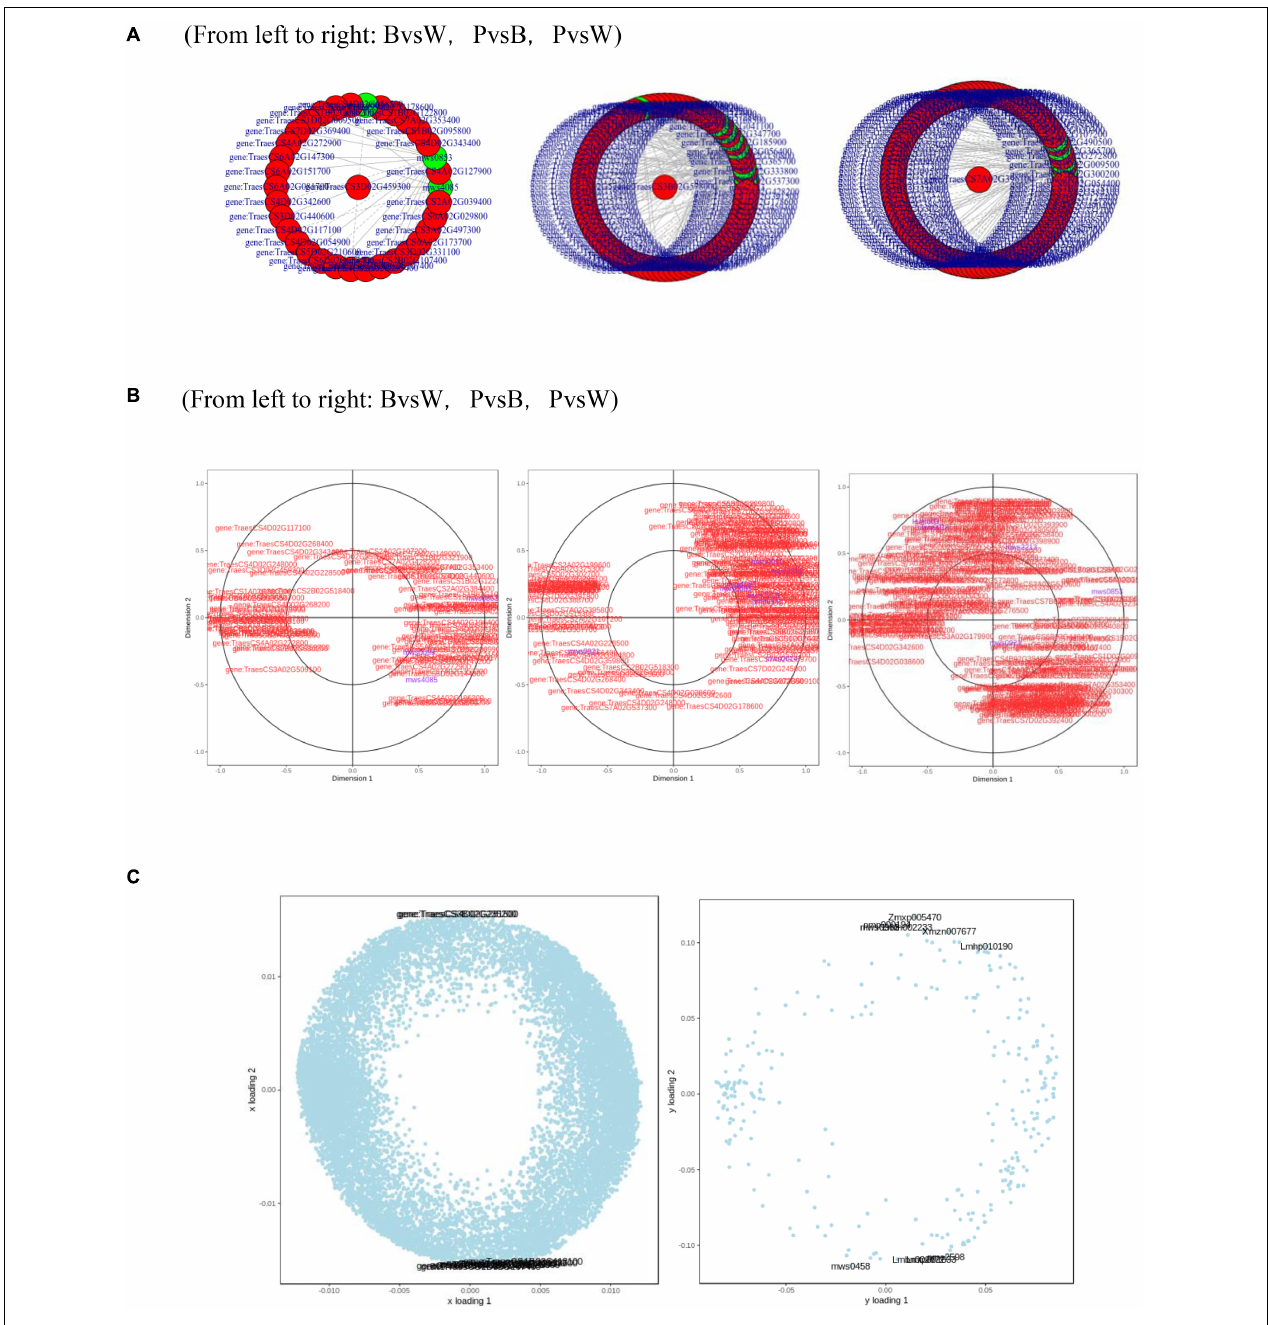
FIGURE 7 | (A) Network diagram of correlations between metabolites and genes. (B) Canonical correlation analysis (CCA). (C) Left, transcriptome loading plot; right, metabolome loading plot. CYP73A, trans -cinnamate 4-monooxygenase; HCT, shikimate O -hydroxycinnamoyltransferase; CHS, chalcone synthase; CHI, chalcone isomerase; CYP75A, flavonoid 3 (cid:48) ,5 (cid:48) -hydroxylase; CYP75B1, flavonoid 3 (cid:48) -monooxygenase; DFR, bifunctional dihydroflavonol 4-reductase; FLS, flavonol synthase; ANS, anthocyanidin synthase; F3H, naringenin 3-dioxygenase; ANR, anthocyanidin reductase.